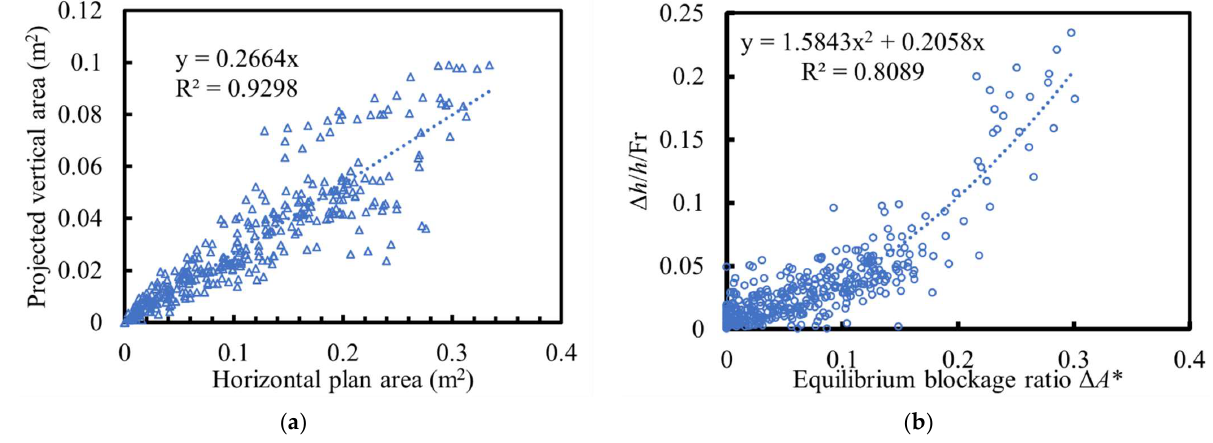
Figure 10. ( a ) Correlation between the horizontal plane area of woody debris jam with the projected vertical area of woody debris jam; ( b ) Correlation between the equilibrium blockage ratio with the hydraulic head.